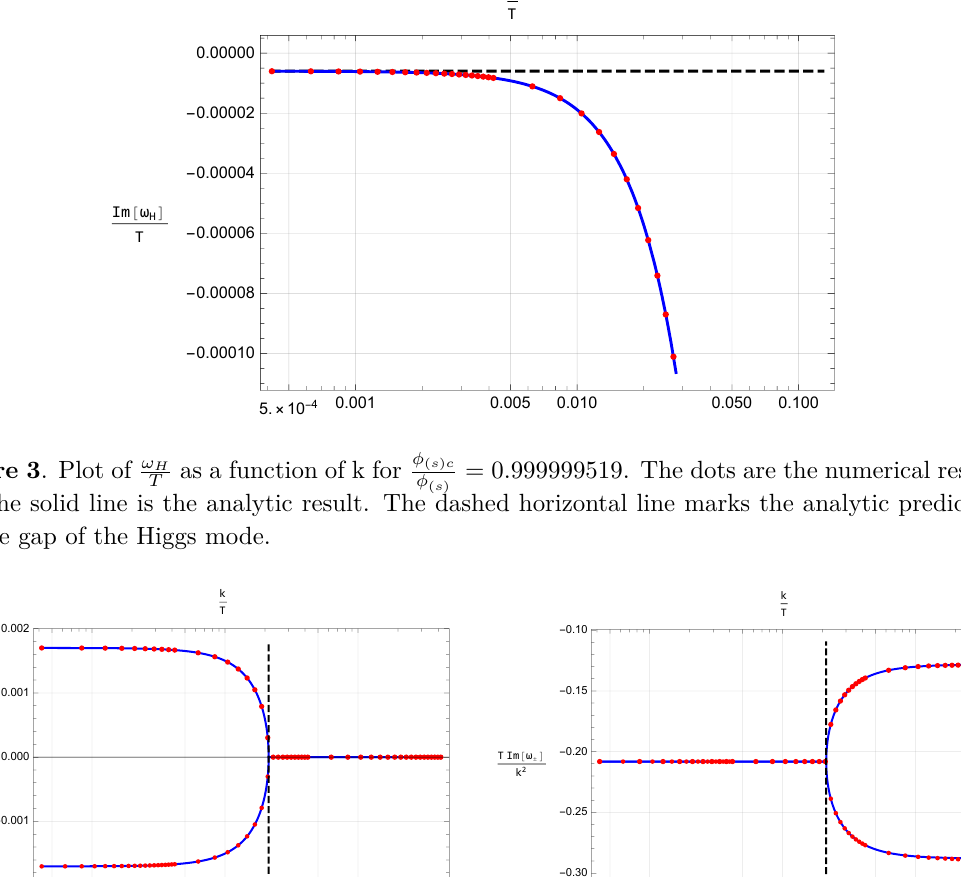
and Imω ± as a function of k for φ ( s ) c k k 2